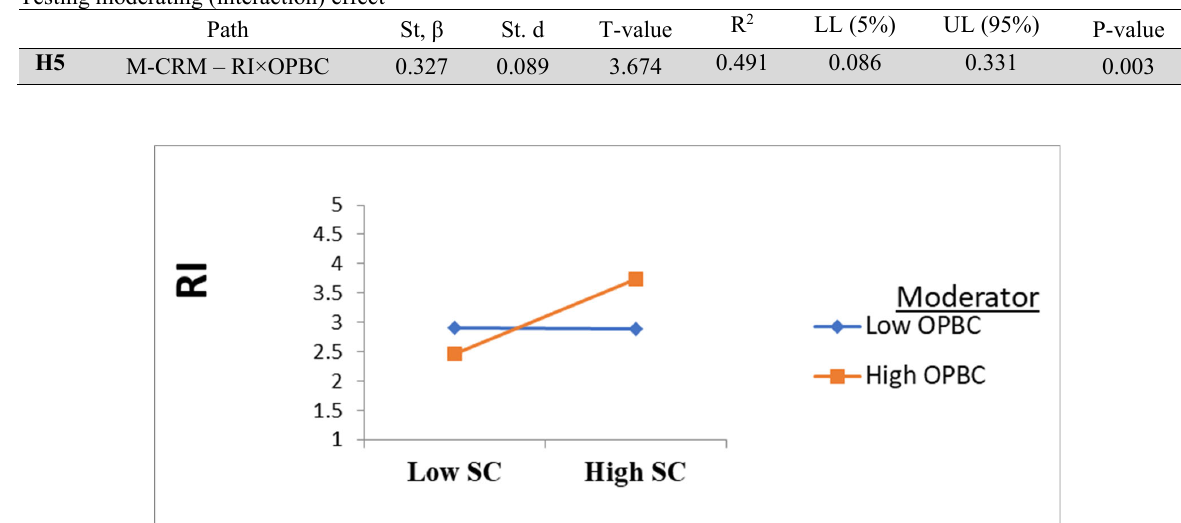
Fig. 4. OPBC moderator (interaction)